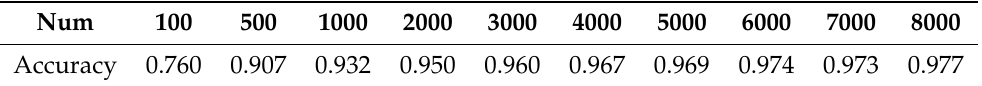
Table 8. Precision results of different neural